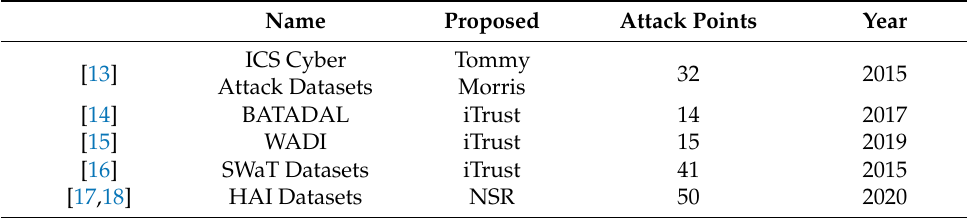
Table 1. Industrial control system operation dataset list.